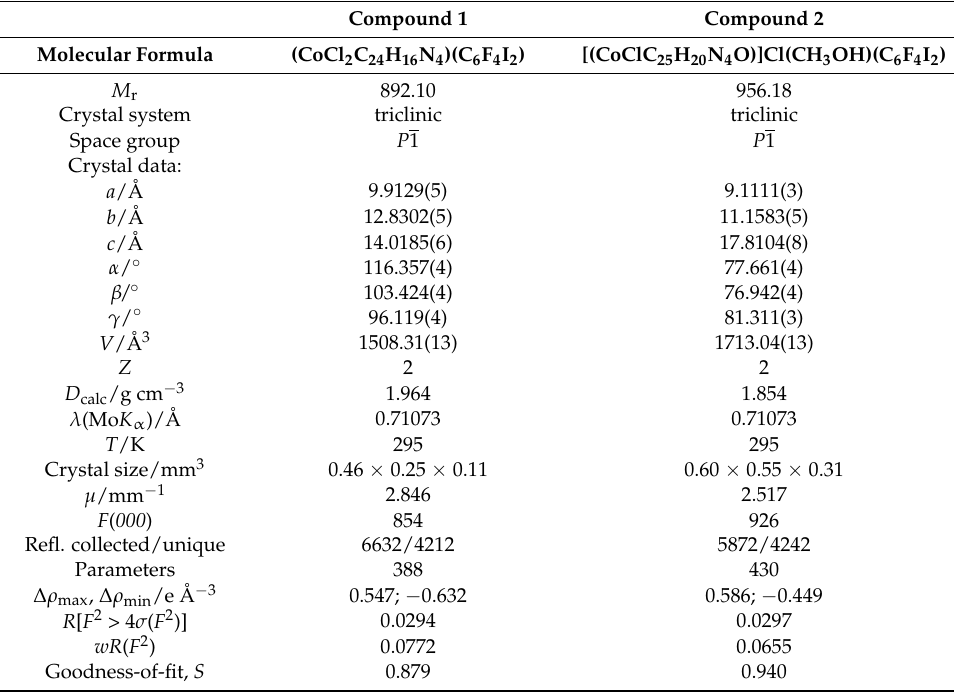
Table 1. General and crystallographic data for the prepared compounds.